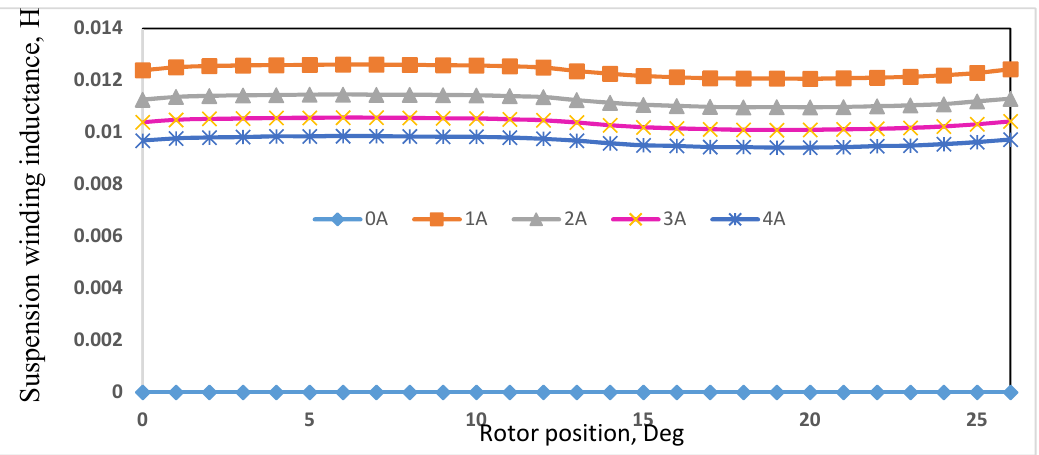
Figure 5. Suspension winding inductance values at different suspension currents.